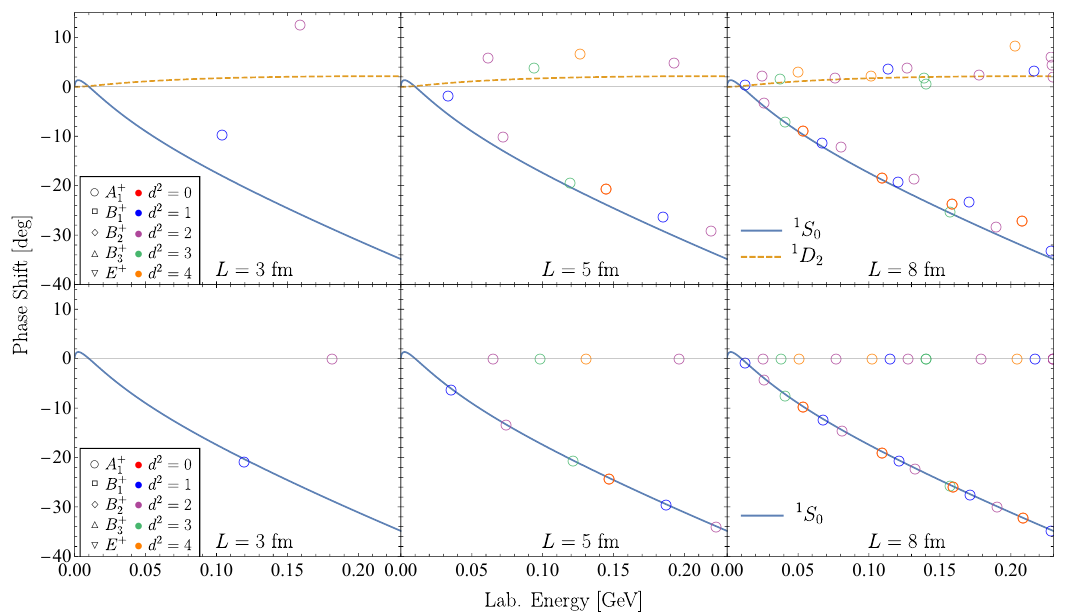
Figure 5 . Phase shifts in the positive-parity channels extracted from the FV energy spectra using the S-wave Lüscher formula (various symbols) in comparison with the infinite-volume results for the OPE potential (upper row) and the S-wave projected OPE potential (lower row). Solid and dashed lines show the 1 S 0 and 1 D 2 phase shifts calculated in the infinite volume, respectively. For remaining notations see figure